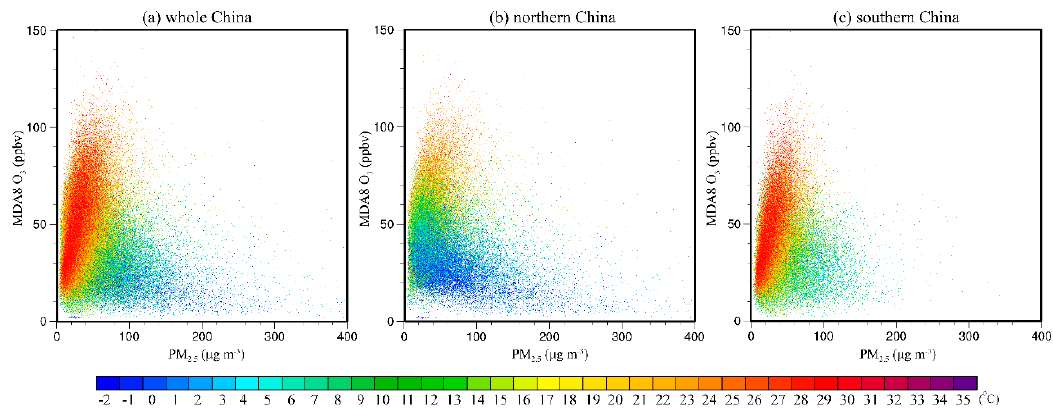
Figure 2. Scatter plots of observed daily PM 2.5 and MDA8 O 3 concentrations color coded with temperature for all cities of the ( a ) whole China, ( b ) northern China, and ( c ) southern China during the year 2016. Northern (southern) China is defined as the area north (south) of 33° N.